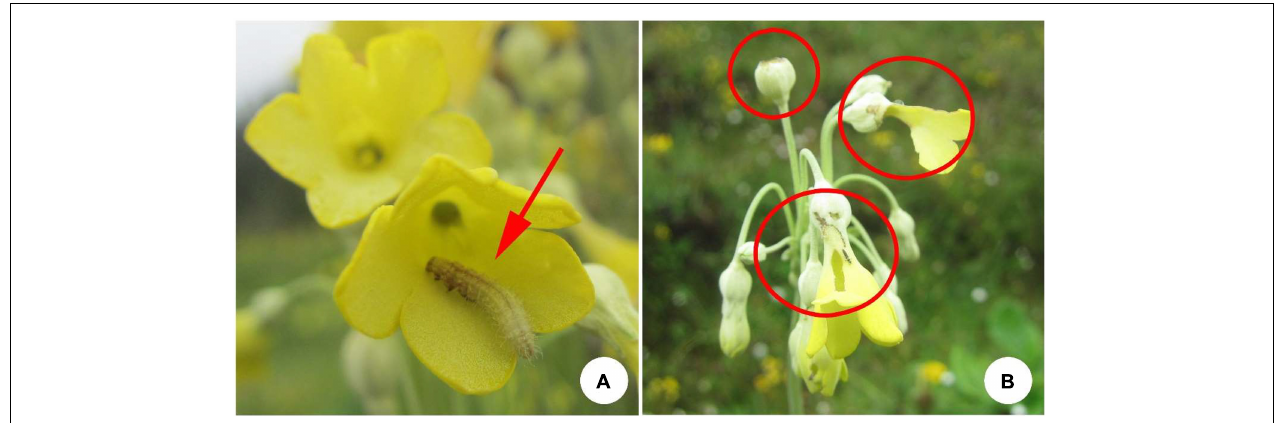
FIGURE 2 | (A) The larvae of the brindle plum moth on a flower of Primula florindae . (B) Damage to flowers of P. florindae caused by the larvae of the brindle plum moth.